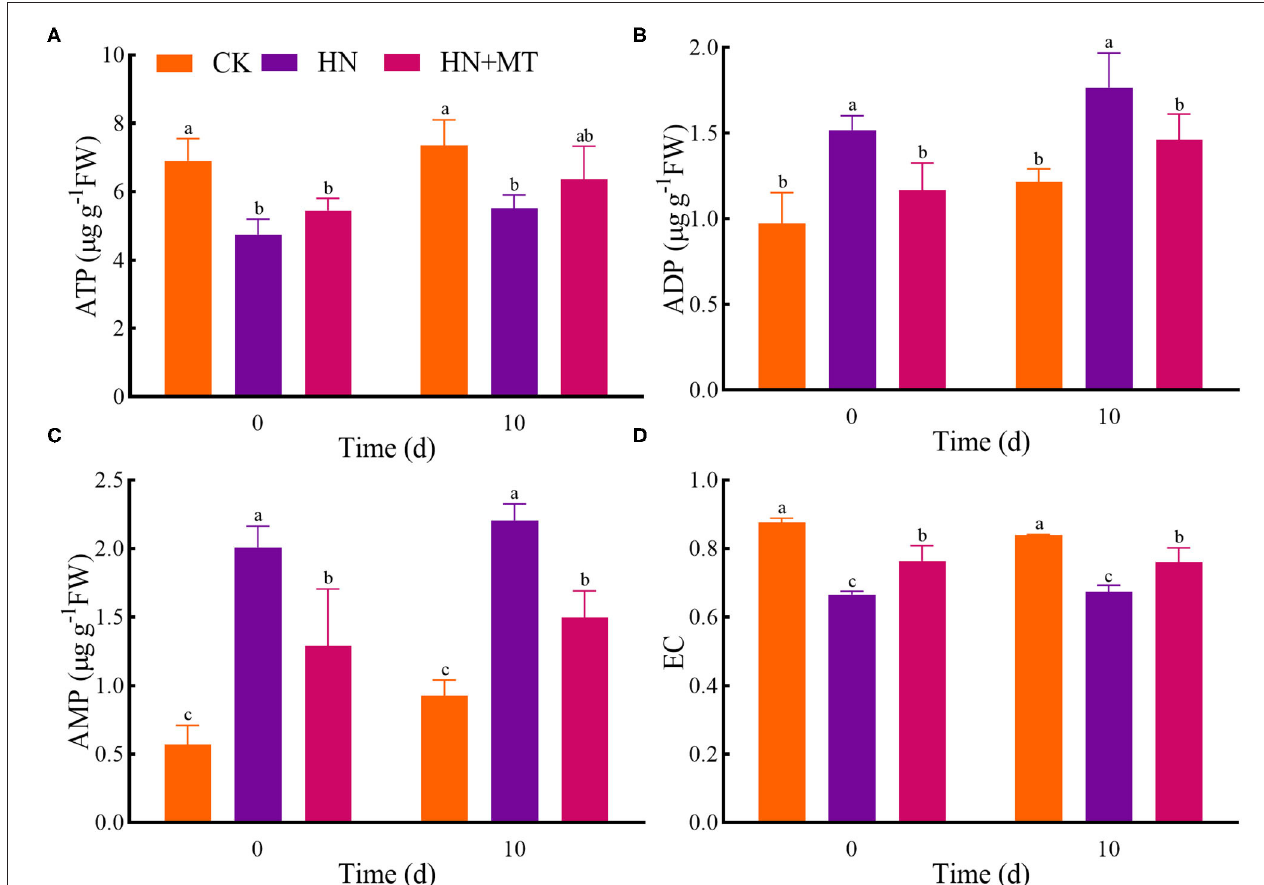
FIGURE 6 | Changes of ATP (A) , ADP (B) , AMP (C) , and EC (D) . The groups on the same day followed with the same letter are not significantly different at p < 0.05. Bars indicate the SDs of the means.